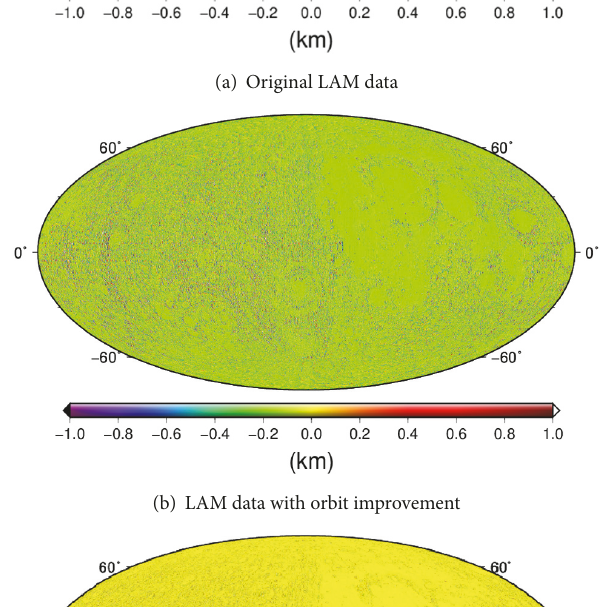
Figure 2: Spectral analysis of LAM residuals.